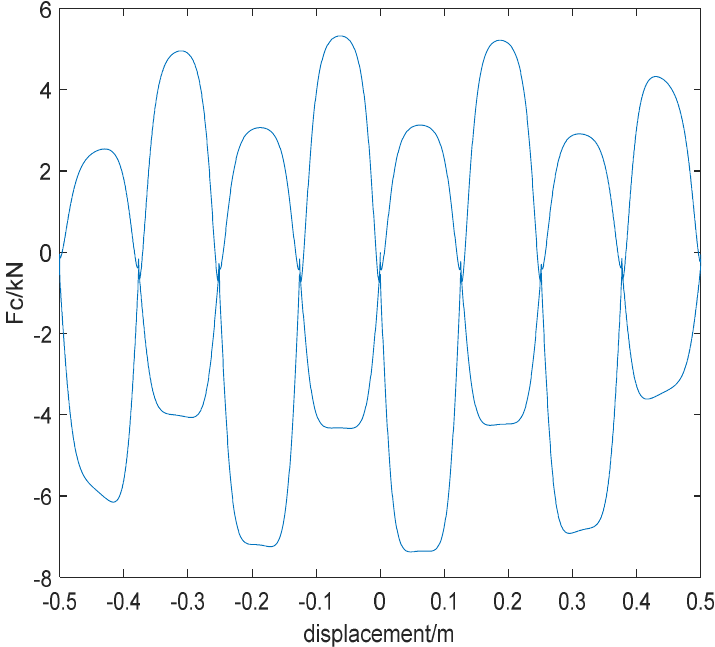
Figure 6.  = 15 and  = 25 damping mechanical model. Figure 6. C = 15 and β = 25 damping mechanical